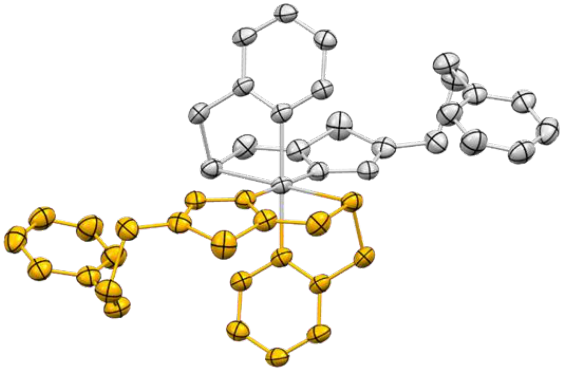
Figure 2. Sketch of the pseudo centrosymmetry of the complex cation representative for all three structures of C1 and C2 .